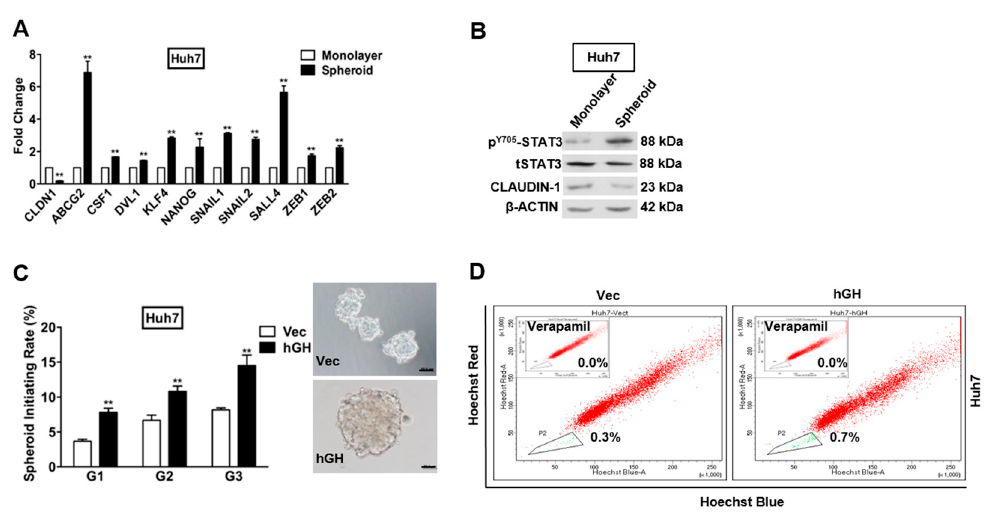
Figure 5. Forced expression of hGH enhances the CSC-like population in HCC cells. ( A ) Reduced expression of CLAUDIN-1 in CSC-enriched Huh7 cells, as compared with monolayer Huh7 cells. CSC medium was used in both conditions. Spheroids were grown in ultra-low attachment plate. ** p < 0.01; ( B ) STAT3 activity and CLAUDIN-1 protein level in Huh7 cells grown under monolayer and spheroid culture conditions. β -ACTIN was used as input control; ( C ) Forced expression of hGH enhances spheroid formation of Huh7 cells. Huh7-Vec/hGH cells were grown under spheroid culture condition, and were sequentially cultured from first generation (G1) till third generation (G3). Images represent the first generation of spheroids formed by Huh7-Vec/hGH cells. Scale bar, 100 µm. ** p < 0.01; ( D ) Forced expression of hGH increases side population (SP) in Huh7 cells. Huh7-Vec/hGH cells were stained with Hoechst 33,342 with or without the ATP-binding cassette (ABC) transporter inhibitor Verapamil for 90 min. Verapamil was used to establish the baseline fluorescence of these cells. The side population within the triangle is represented by green dots, while the non-side population is represented by red dots. Flow cytometry plots indicate Hoechst Red versus Hoechst Blue. To determine the effect of forced expression of hGH on the CSC-like properties of HCC cells, Huh7 and Hep3B cells with forced expression of hGH were cultured under ultra-low attachment conditions. Huh7 and Hep3B cells with forced expression of hGH exhibited significantly increased growth (number) of spheroids compared with the respective -Vec cells (Figures 5C and S6C). To